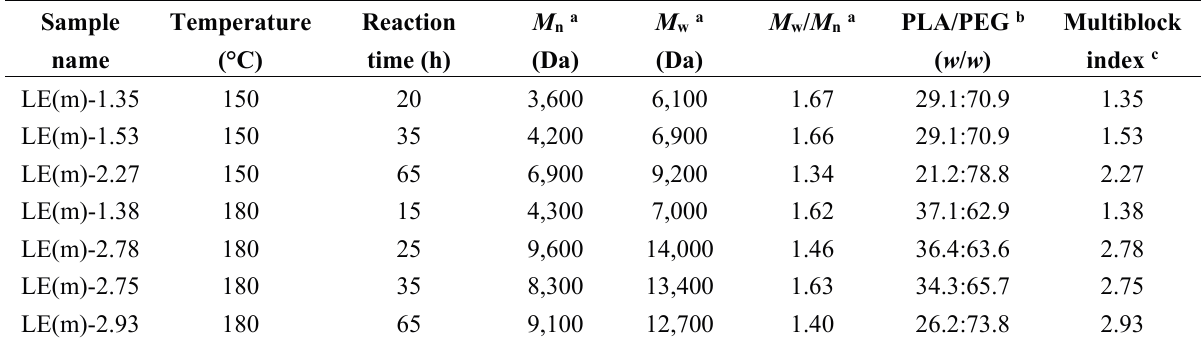
Table 1. Characteristics of the PLA–PEG